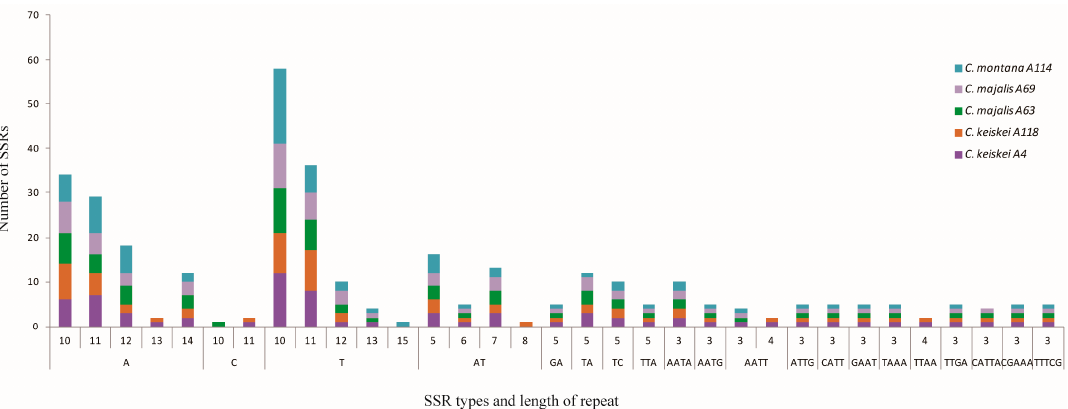
Figure 6. Distribution of simple sequence repeats (SSRs) in the five Convallaria chloroplast